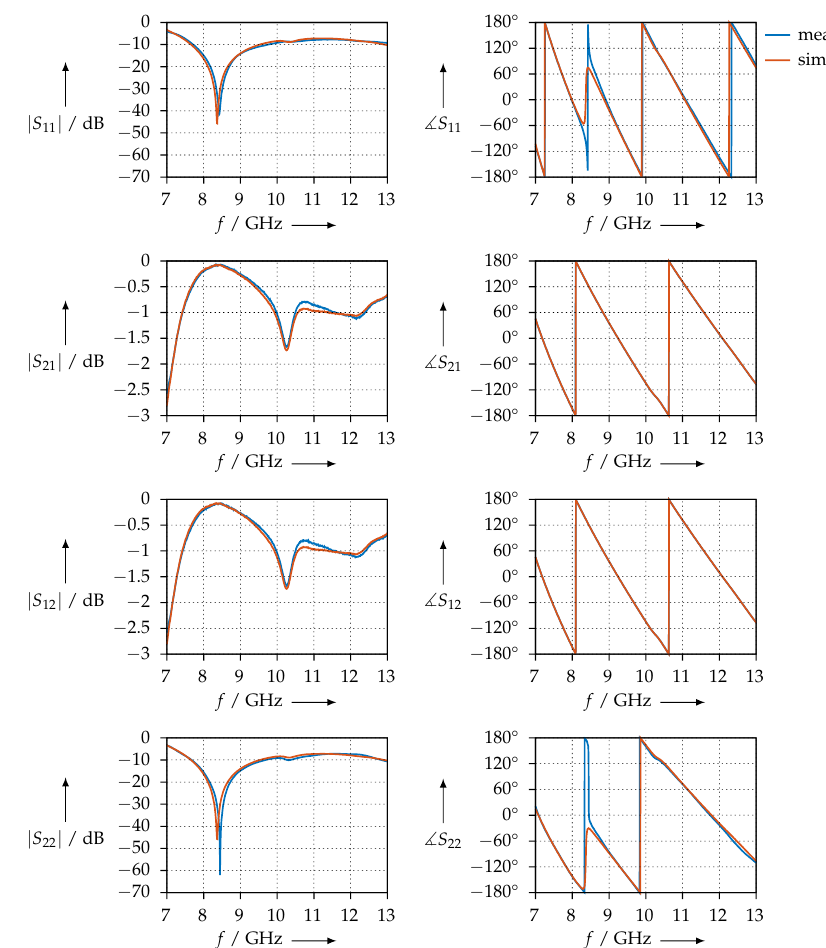
Figure 9. Measured and simulated S-parameters of the PTFE sample in the